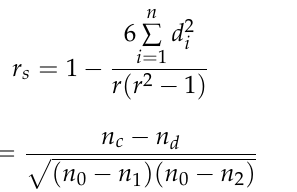
Table 4. Spearman’s Rho correlations with moderate to strong range 0.51 to 0.75 and comparison to Kendall’s Tau b correlation model.